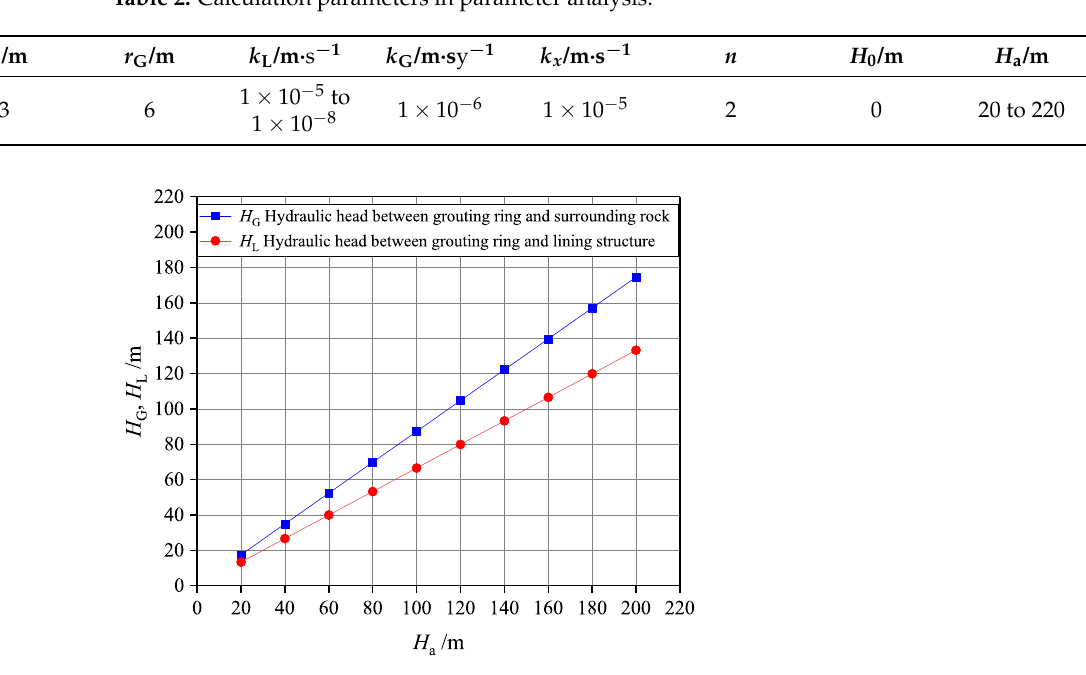
Figure 7. Hydraulic head of grouting ring and lining structure under different total hydraulic head at infinite